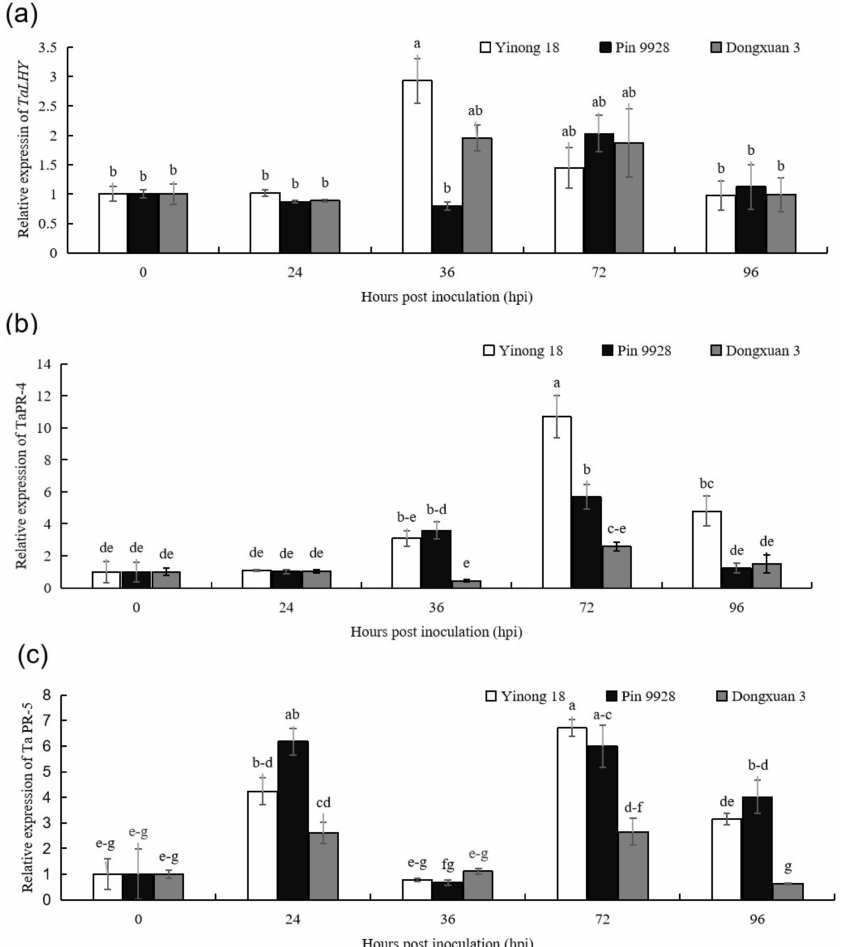
Figure 1. Expression profiles of TaLHY , TaPR-4 , and TaPR-5 in resistant (Yinong 18), moderately resistant (Pin 9928), and susceptible (Dongxuan 3) wheat cultivars at different time intervals after T. controversa infection. ( a ) relative expression of TaLHY; ( b ) relative expression of TaPR-4; ( c ) relative expression of TaPR-5 . The T. controversa treatment at every time point is normalized at 0 hpi. The significant differences were statistically analyzed based on three biological replications and four technical replications (Tukey’s test: p < 0.05). Bars indicate the standard errors. Lettering above the bars showed level of